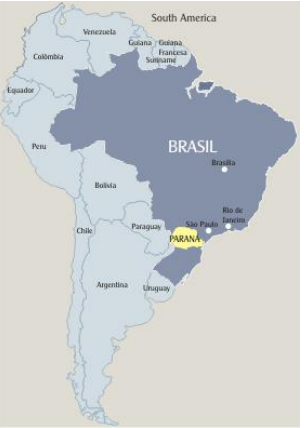
Figure 1. Location of Paraná State in the Brazil map [4].